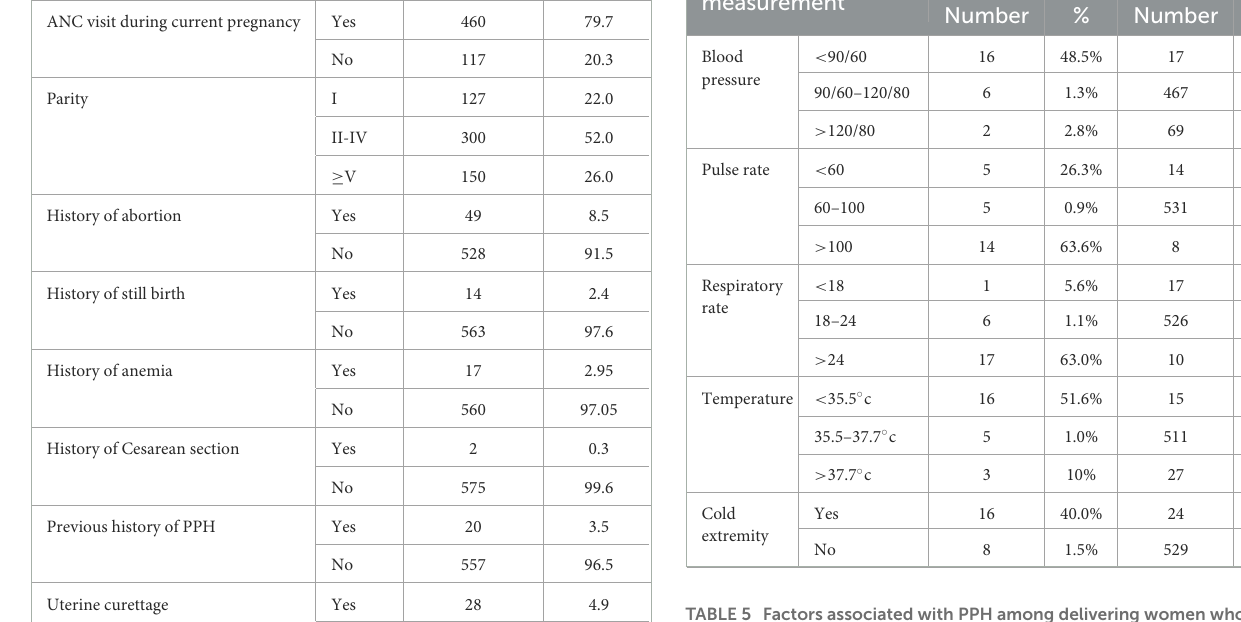
TABLE 5 Factors associated with PPH among delivering women who give delivery in the district areas health centers of Gedeo Zone, Southern Ethiopia, 2021 ( N =